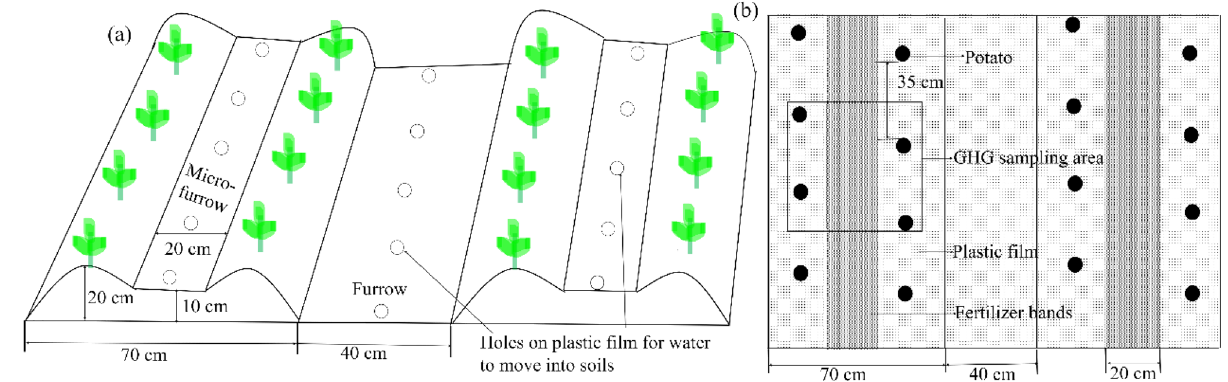
Figure 1. Experimental layout for ridge-furrow with plastic film mulching cultivation